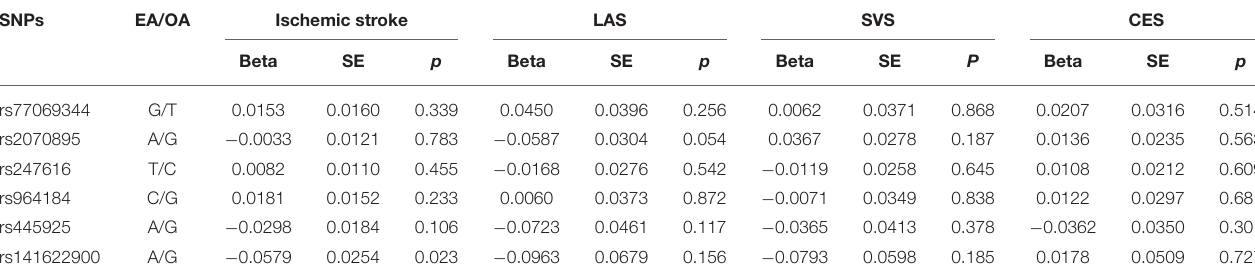
TABLE 4 | Genetic association of cholesterol efflux capacity related genetic variants with ischemic stroke and its subtypes in the MEGASTROKE consortium. SNPs EA/OA Ischemic stroke